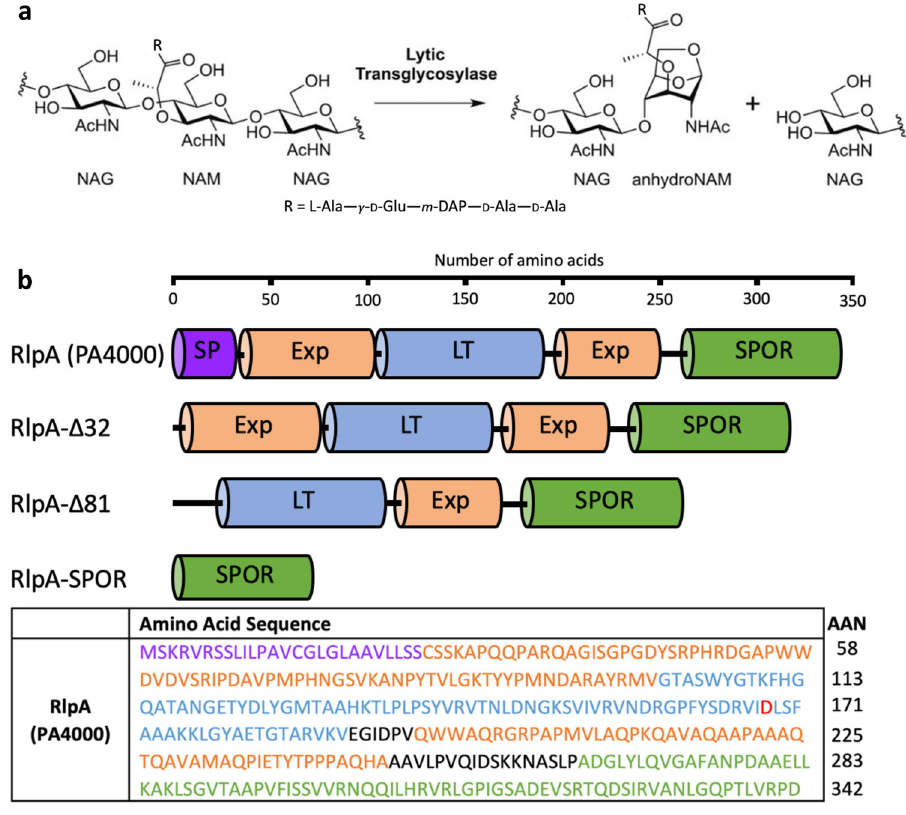
Fig. 1 Schematic representations of LT reaction, RlpA constructs, and primary structure of RlpA. a LTs catalyze the non-hydrolytic cleavage of the NAM-NAG glycosidic bond. NAG denotes N -acetylglucosamine and NAM denotes N -acetyl muramic acid. While a peptide stem is attached ordinarily to the lactyl of the NAM unit (R = peptide stem), RlpA acts on lactyl-unsubstituted, or denuded, peptidoglycan (R is oxygen, giving a carboxylate functional group). b Primary structure is shown for RlpA (Pseudomonas Genome Database, Cystic Fibrosis Foundation, Therapeutics). “ SP ” in purple denotes N - terminal signal peptide; amino acids 1 – 26. The linker sequence (amino acids 27 – 81) is colored orange to re fl ect its probable identity as part of the expansin domain. “ LT ” in blue denotes lytic transglycosylase domain: amino acids 102 – 189. “ Exp ” in orange denotes expansin-type domain: amino acids 196 – 246. “ SPOR ” in green denotes peptidoglycan-binding SPOR domain: amino acids 264 – 342. Catalytic aspartate in the LT domain is highlighted red: amino acid 168. AAN denotes the number of amino acids in each line of the